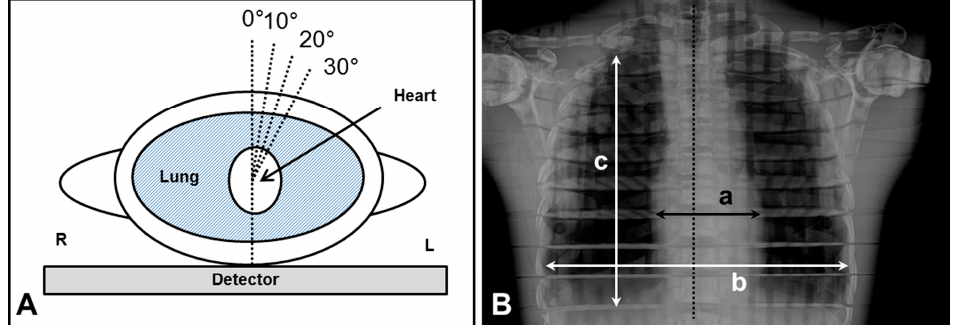
Figure 4. The angulation plane ( A ) and reference line setting ( B ) for the measurement of distortion on chest phantom: (a) cardiac transverse diameter (CTD); (b) thoracic transverse diameter (TTD); and (c) thoracic longitudinal diameter (TLD). L and R indicated left side and right side.